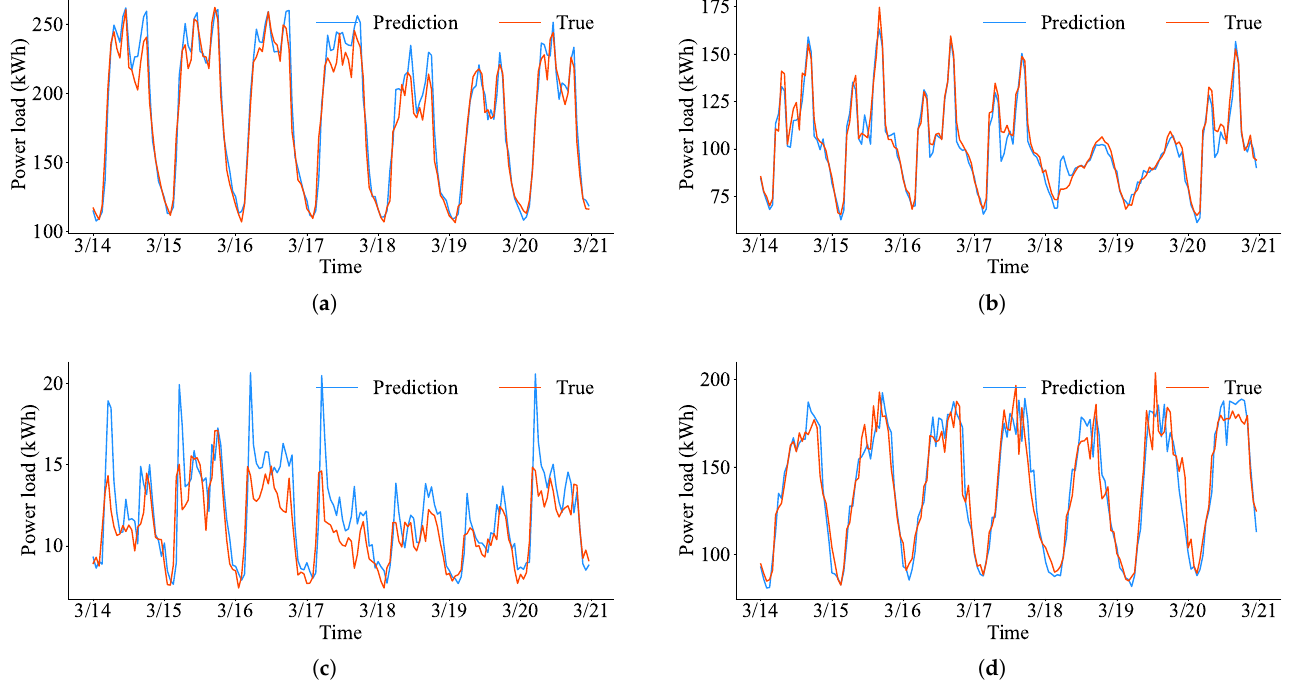
Figure 6. The power load forecasting curves for four buildings. ( a ) Task B → A; ( b ) task C → B; ( c ) task A → C; ( d ) task C →